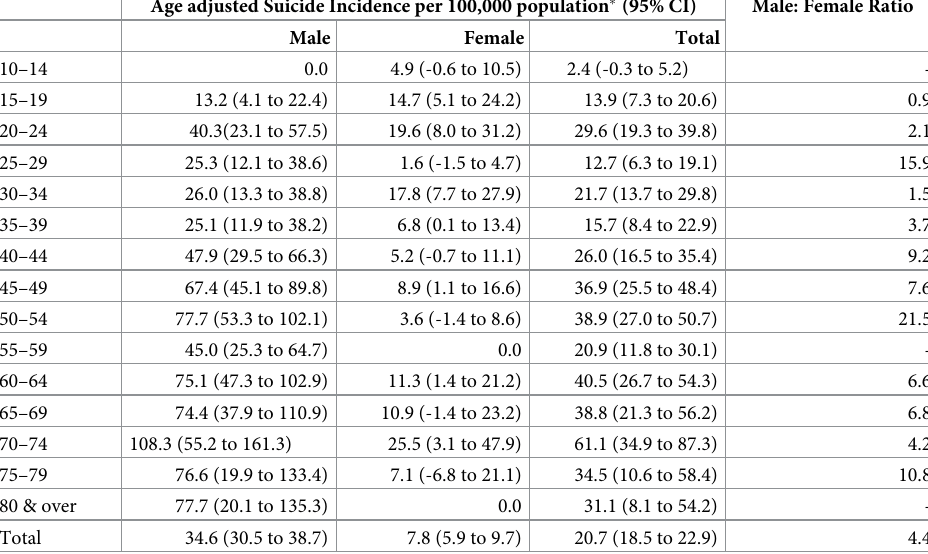
Table 6. Age standardized suicide incidences in KD in 2012 among males and